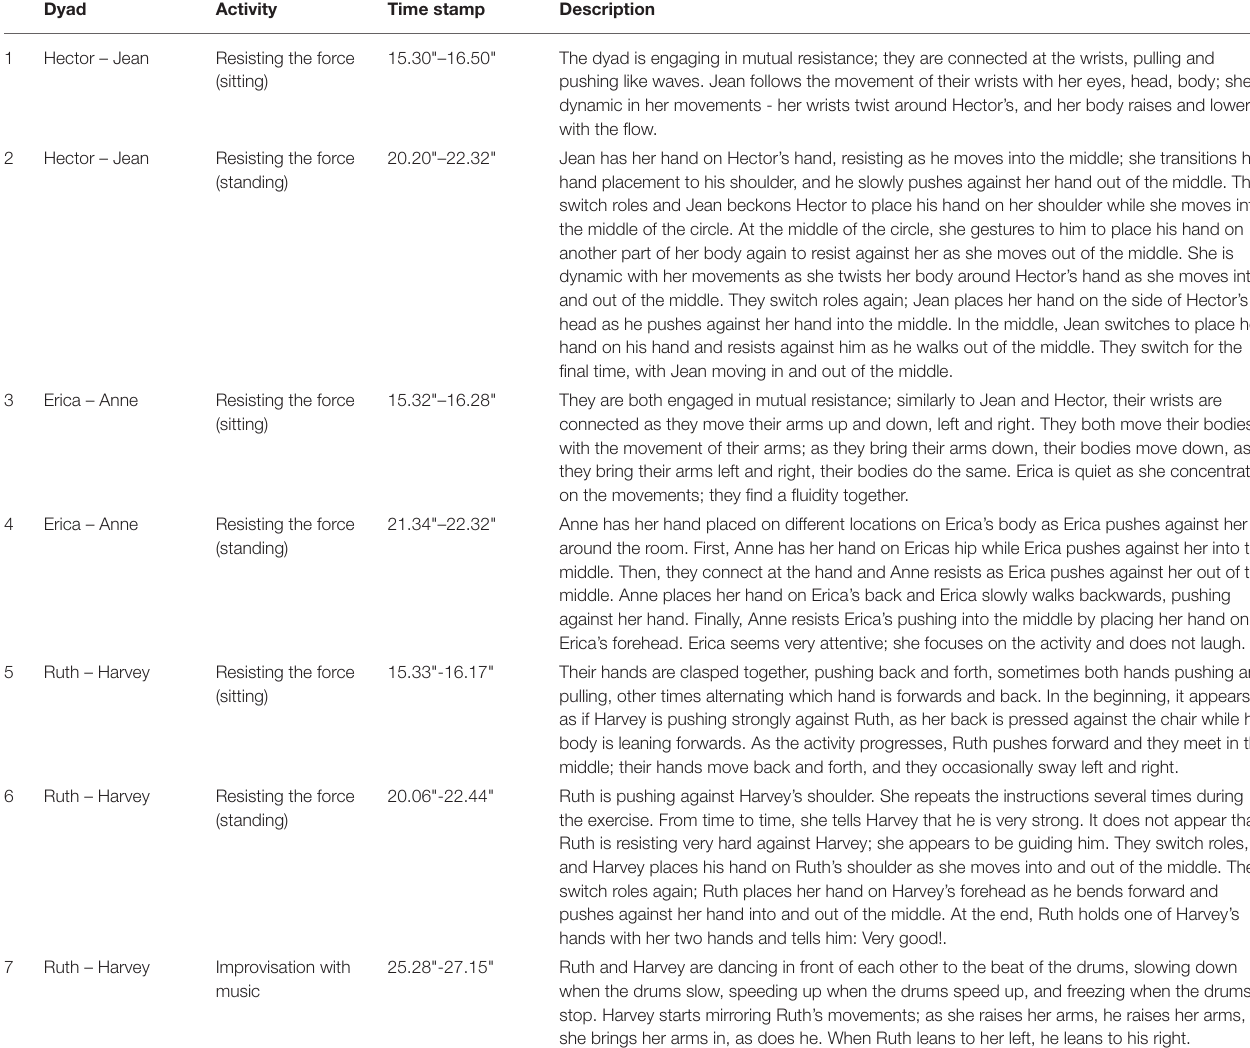
TABLE 2 | Description of moments of connection from video